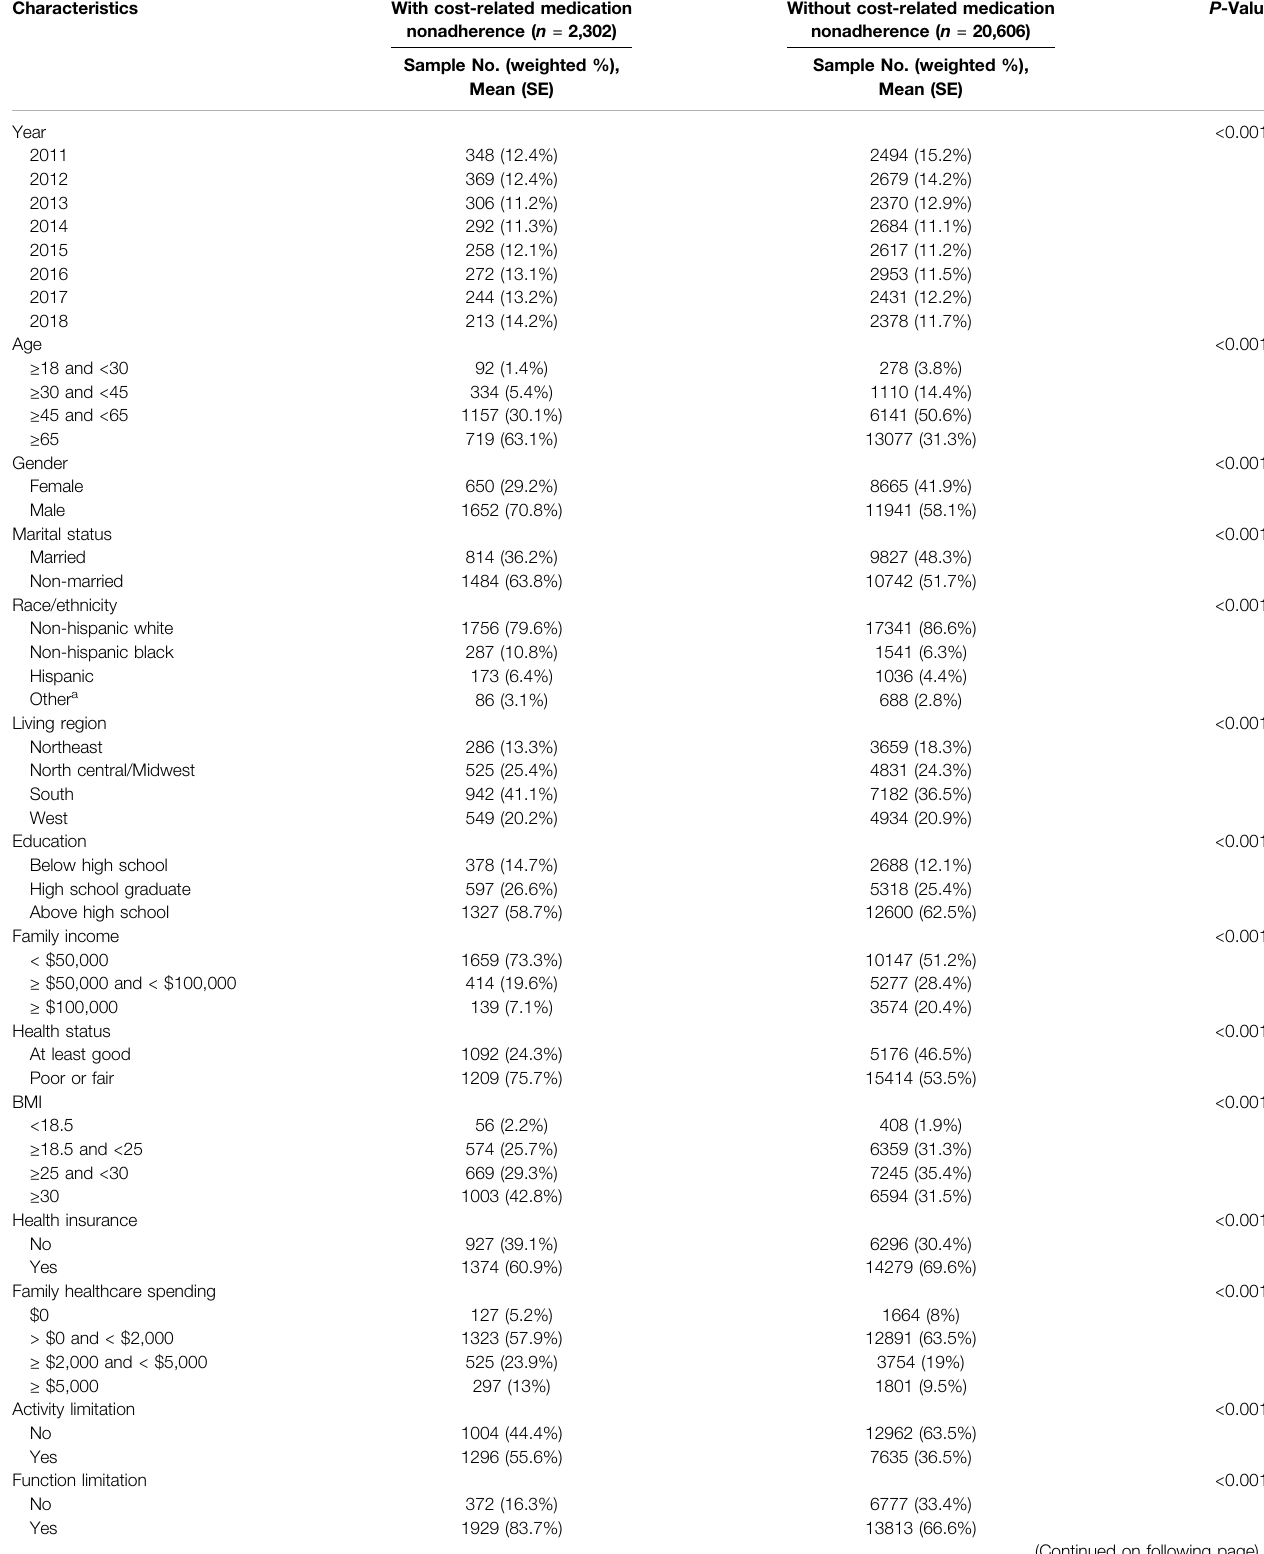
TABLE 1 | Baseline characteristics of cancer survivors with or without cost-related medication nonadherence.